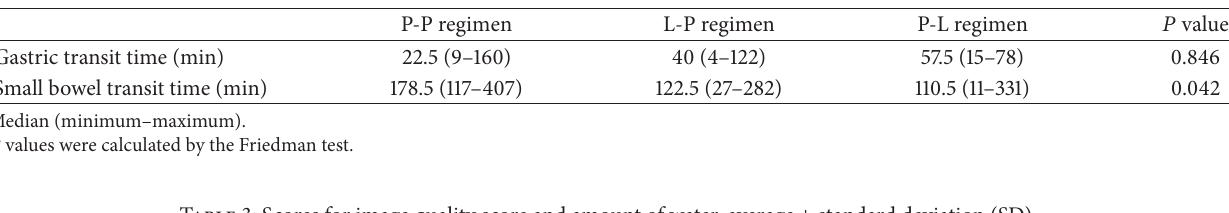
Table 3: Scores for image quality score and amount of water, average ± standard deviation